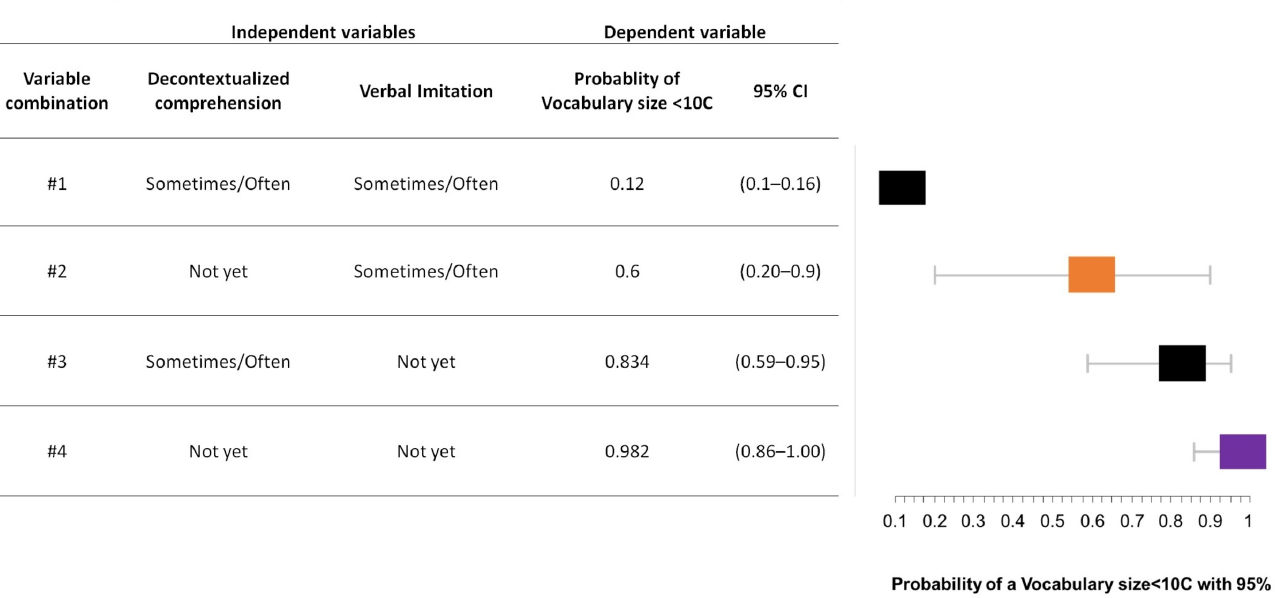
Figure 4. Probability of having a vocabulary size below the 10th percentile at 27–30 months of age associated with the possible combinations among the different levels of the variables entered in the associated with the possible combinations among the di ff erent levels of the variables entered in the best multivariable best multivariable model.